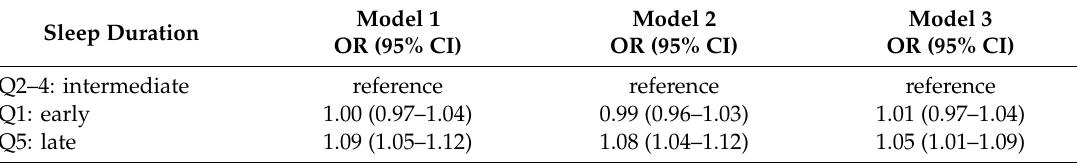
Table 3. Adjusted odds ratio for adolescent asthma risk by sleep